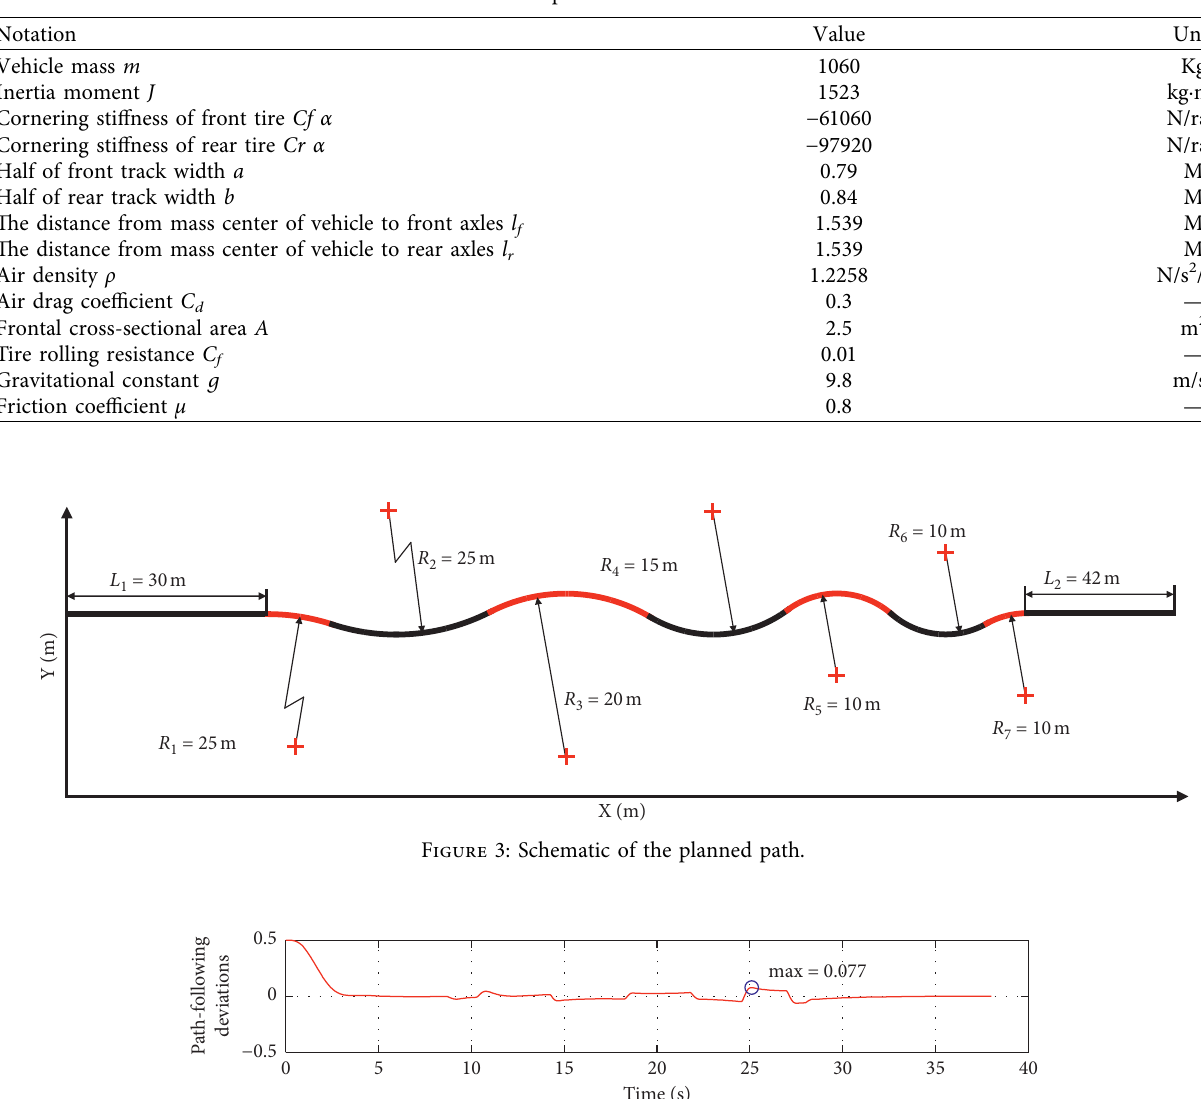
Table 1: Vehicle parameters used in simulation.